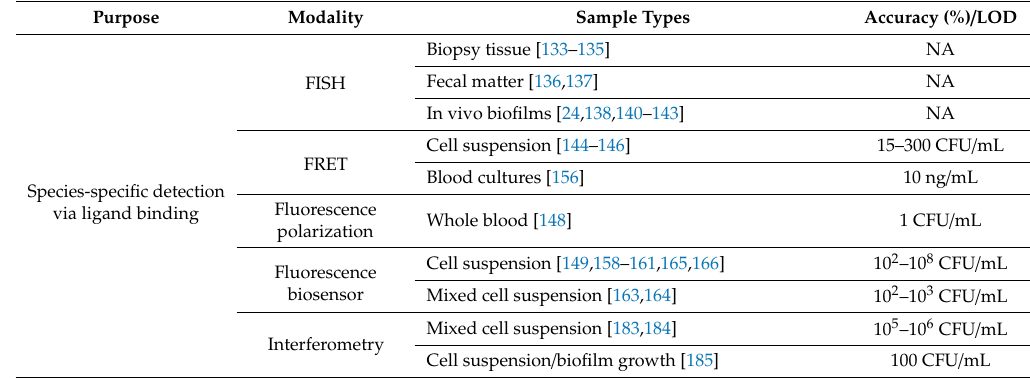
Table 3. Comparison of application, sample type and accuracy / limit of detection (LOD) for various optical